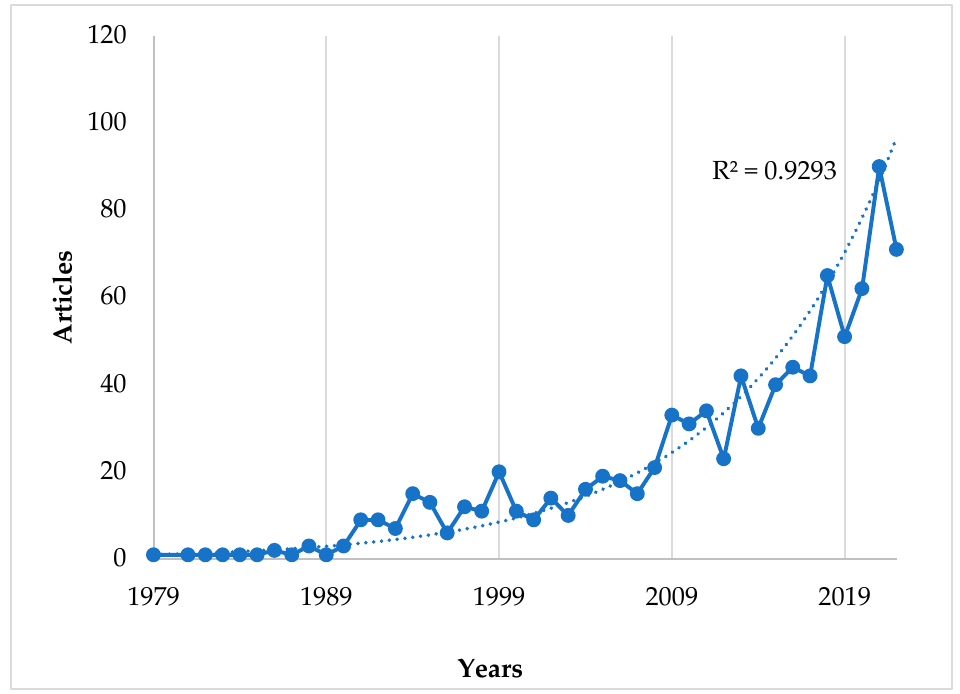
Figure 3. Intertemporal evolution of academic production on MCDM.